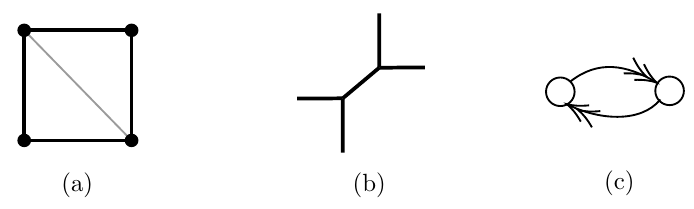
Figure 2 . (a) The toric diagram for C . (b) Its dual web diagram. (c) The corresponding